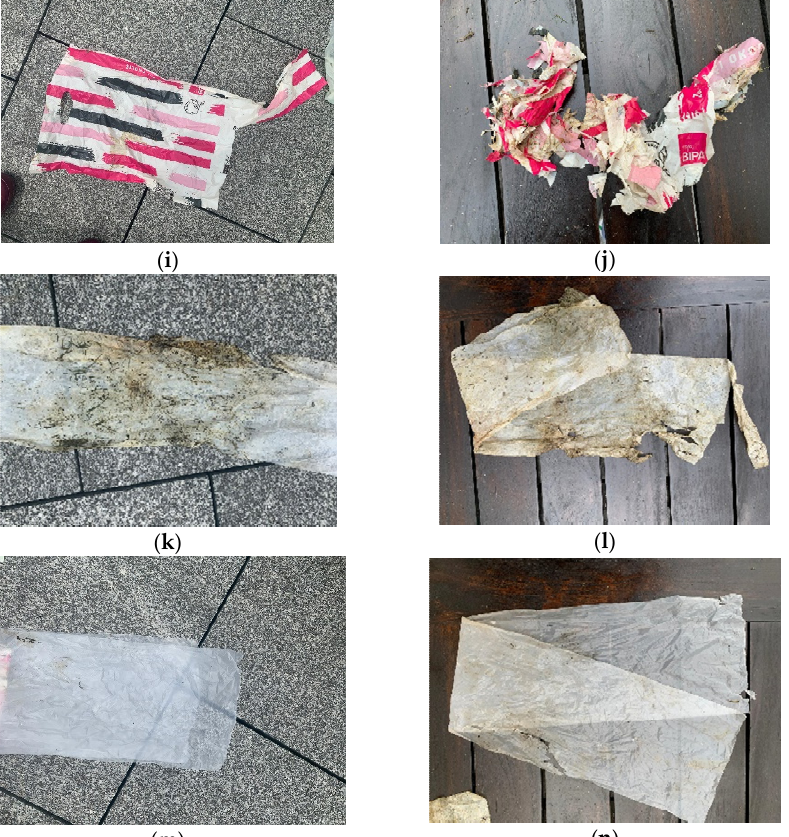
Figure 4. Degradation of films after the third and fourth month: ( a ) B0 after 3 months, ( b ) B0 after 4 months, ( c ) SP after 3 months, ( d ) SP after 4 months, ( e ) SW after 3 months, ( f ) SW after 4 months, ( g ) B1 after 3 months, ( h ) B1 after 4 months, ( i ) B2 after 3 months, ( j ) B2 after 4 months, ( k ) Eco after 3 months, ( l ) Eco after 4 months, ( m ) K after 3 months, ( n ) K after 4 months. The figure shows all 7 films only after the third and the fourth month because in most cases after the first and even after the second month no change and decomposition was visually observed.